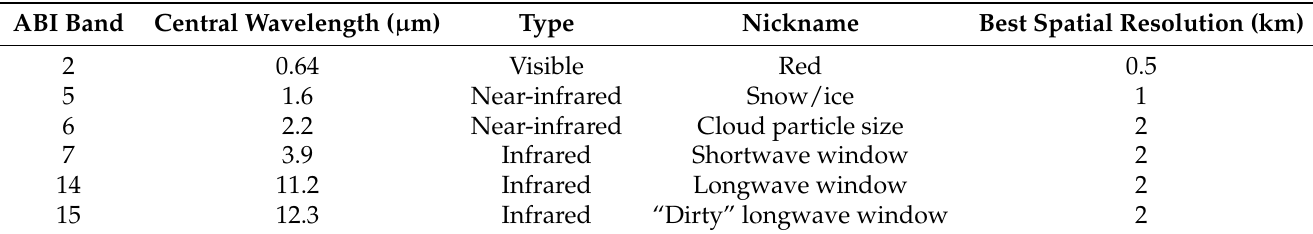
Table 1. Advanced Baseline Imager (ABI) channels used for dynamic feature generation. Specifications reproduced from [26]. ABI